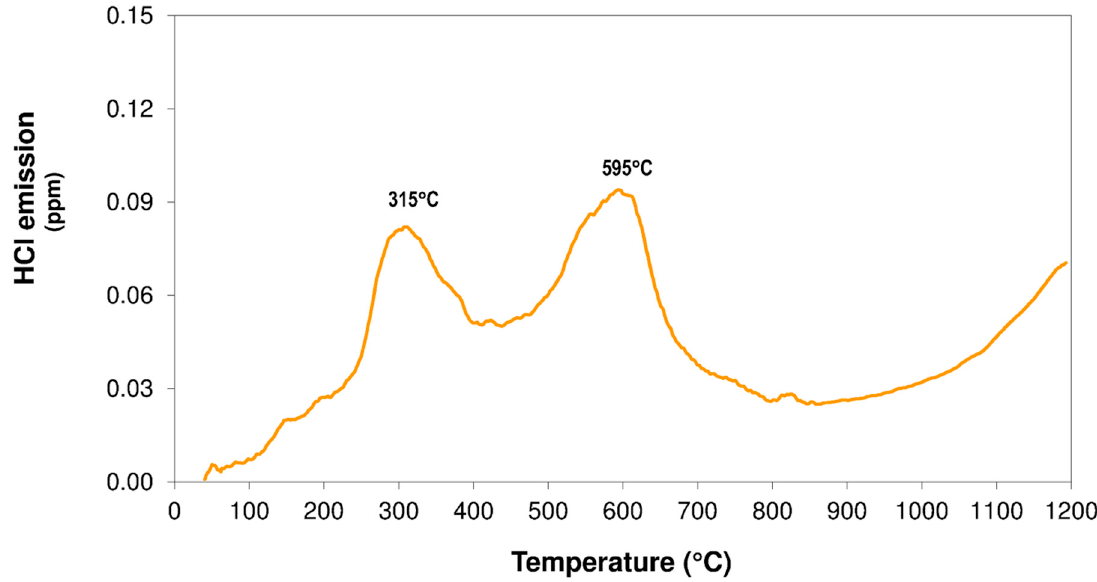
Figure 5. HCl curve emission for sample BCS-CRM 348 Ball clay.